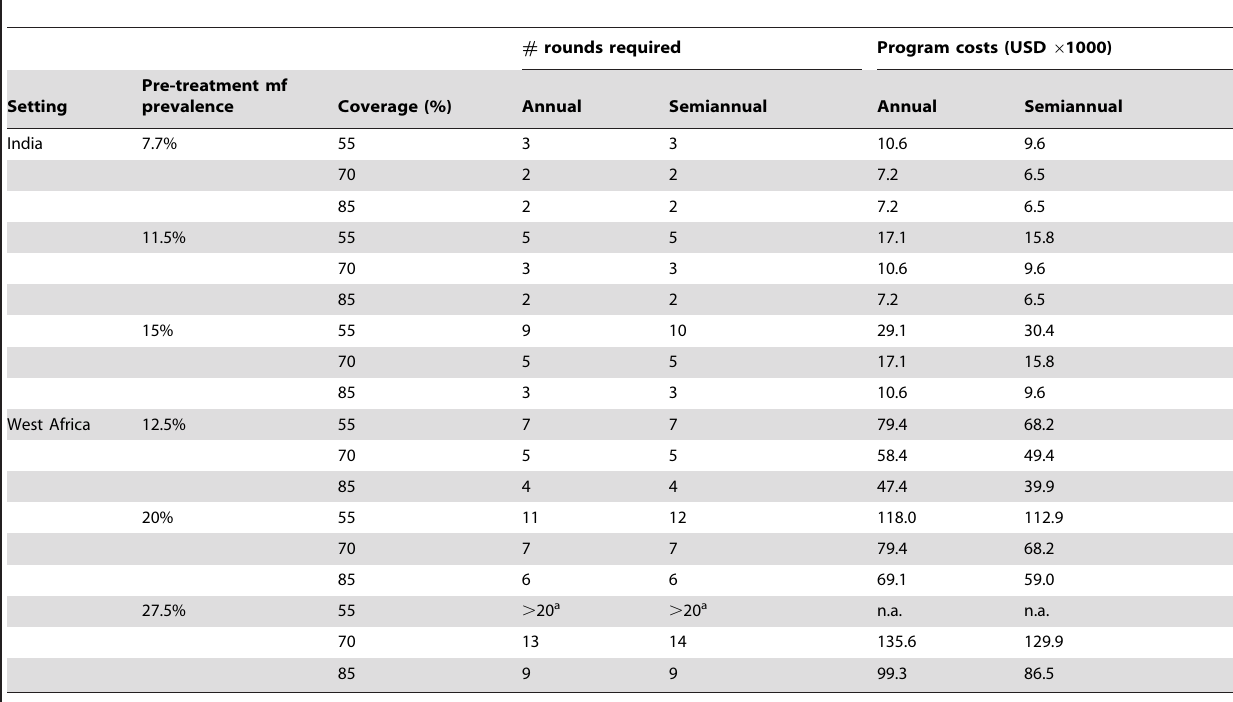
Table 4. Number of treatment rounds required for elimination and total costs of mass drug administration